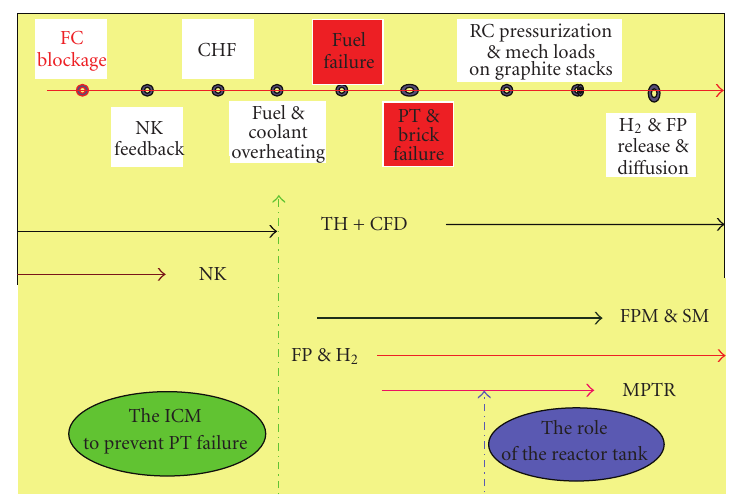
Figure 2: Evolution of the RBMK FC blockage